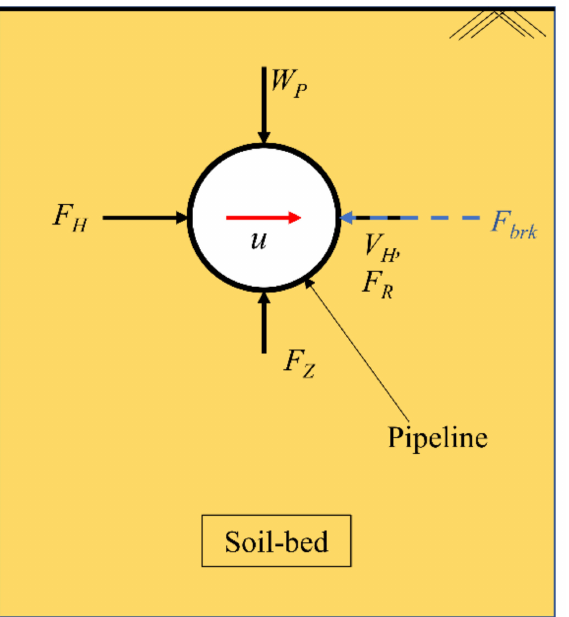
Figure 5. A schematic diagram showing the direction and location of the forces used in the Equations